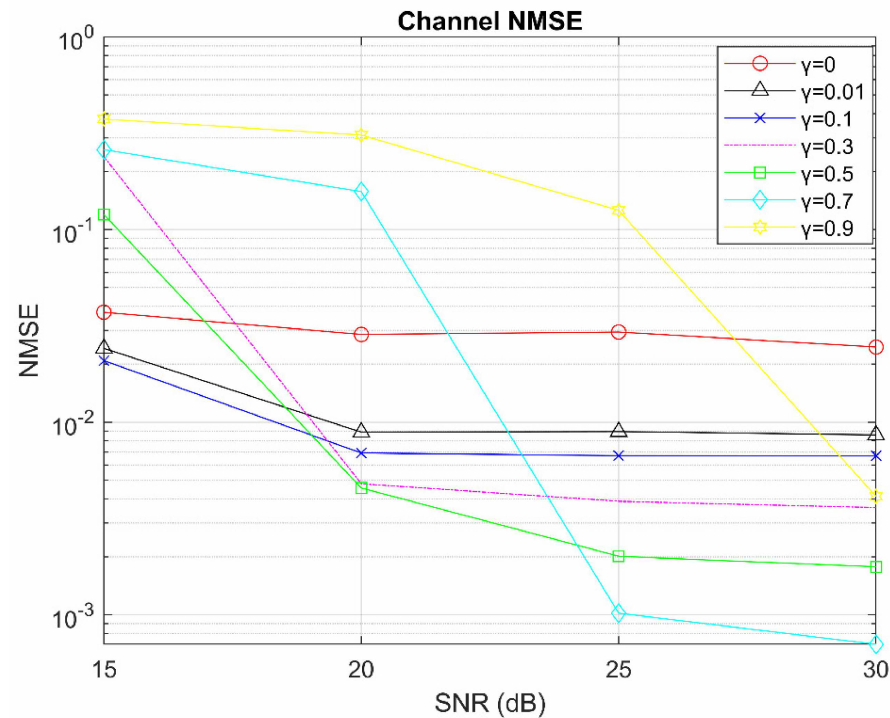
Figure 8. NMSEs of channel estimation schemes versus the system SNR and values of γ with R = 4, λ = 10 − 4